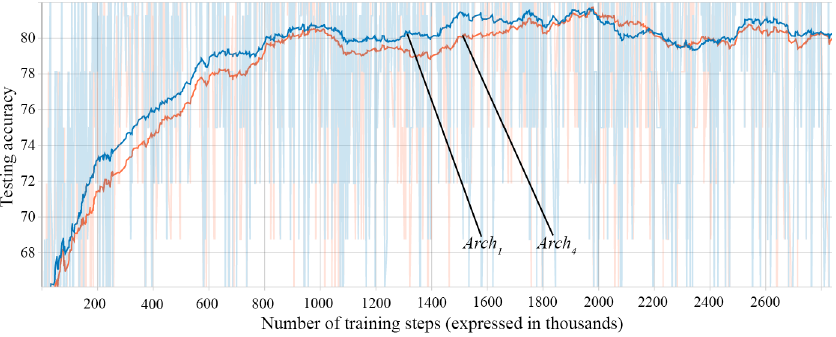
Figure 9. Test accuracies according to memory cells: Arch 1 —GRU (blue) and Arch 4 —LSTM